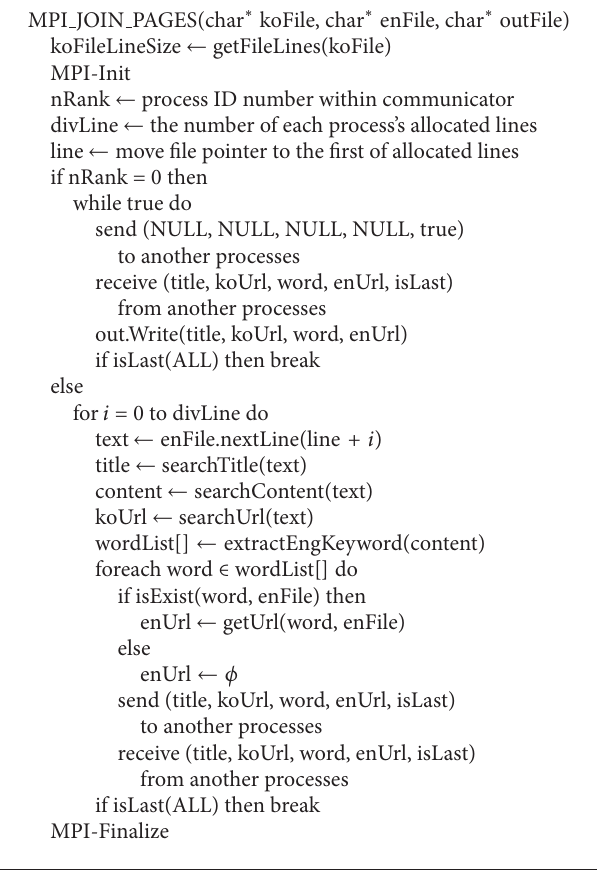
Algorithm 6: MPI pseudocode for the join problem.